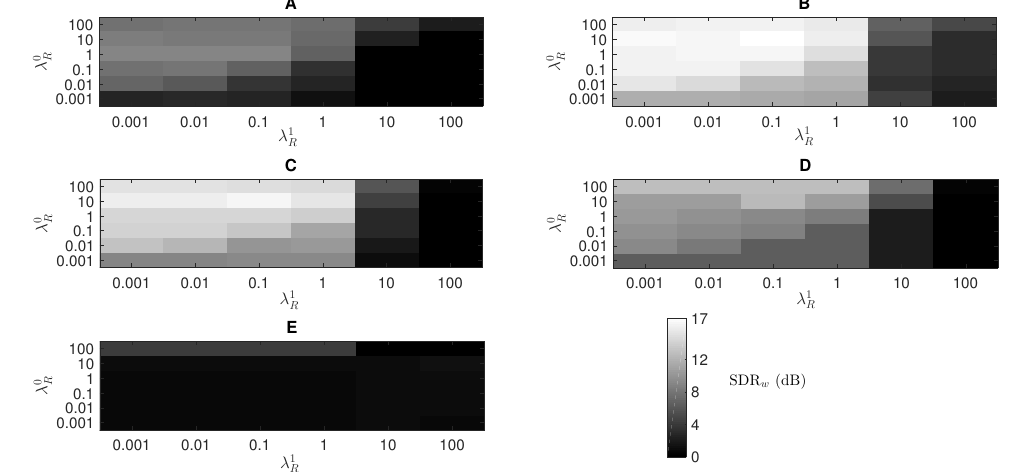
Figure 5. SDR w average results from the hyperparametric optimization of the proposed method varying the parameters λ W , λ 0 and λ 1 . The rest of parameters are the following: K W = 64, K R = 32 R R and α = 1. ( A ) λ W = 0.001, ( B ) λ W = 0.01, ( C ) λ W = 0.1, ( D ) λ W = 1 and ( E ) λ W =